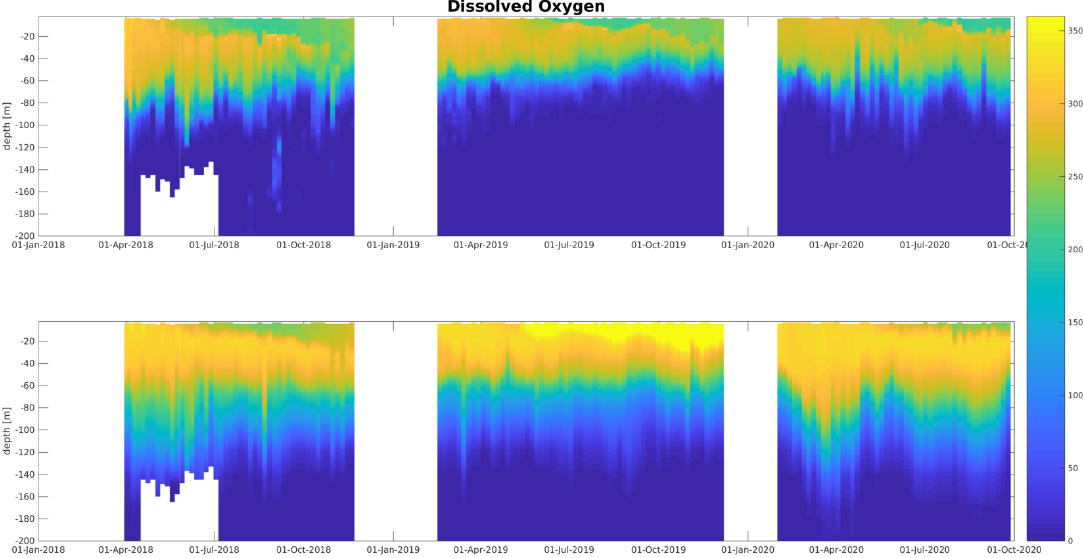
Figure 9. BGC-ARGO (top) and modelled (bottom) vertical profiles of oxygen from 2018 to 2020. In April 2019, the dissolution of oxygen was overestimated, which is probably due to an underestimation of the SST. As shown in Figure 10, on the north-western shelf, the model (in orange) seems to capture the main characteristics of the observed seasonal cycle (in blue), with an oxygenation of the water column in winter due to ventilation and surface photosynthesis, and a reduction later in the year in response to decreased dissolution and the intensification of respiration. The model tends to underestimate the oxygen concentration on the surface in winter time (Jan–Mar) (Figure 10 left), and does the reverse in the bottom layer in summer–autumn time (Jun–Dec), except in winter when the water column is not stratified (Figure 10 right). The model underestimates the oxygenation of the water column in winter, while later in the year, the underestimation of the surface values and the overestimation of the bottom oxygen could indicate an underestimation of the level of primary production. The lower difference between surface and bottom values in the model as compared to the observations suggests excessive mixing in the model. From July to September, the model simulates hypoxia (O 2 < 63 µ mol kg − 1 ) in the northernmost part of the shelf; however, the number of hypoxic records is